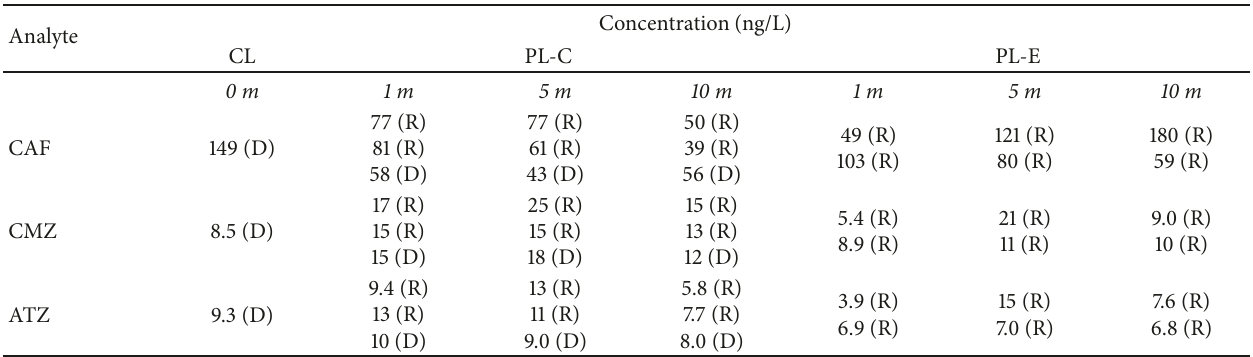
Concentration (ng/L)